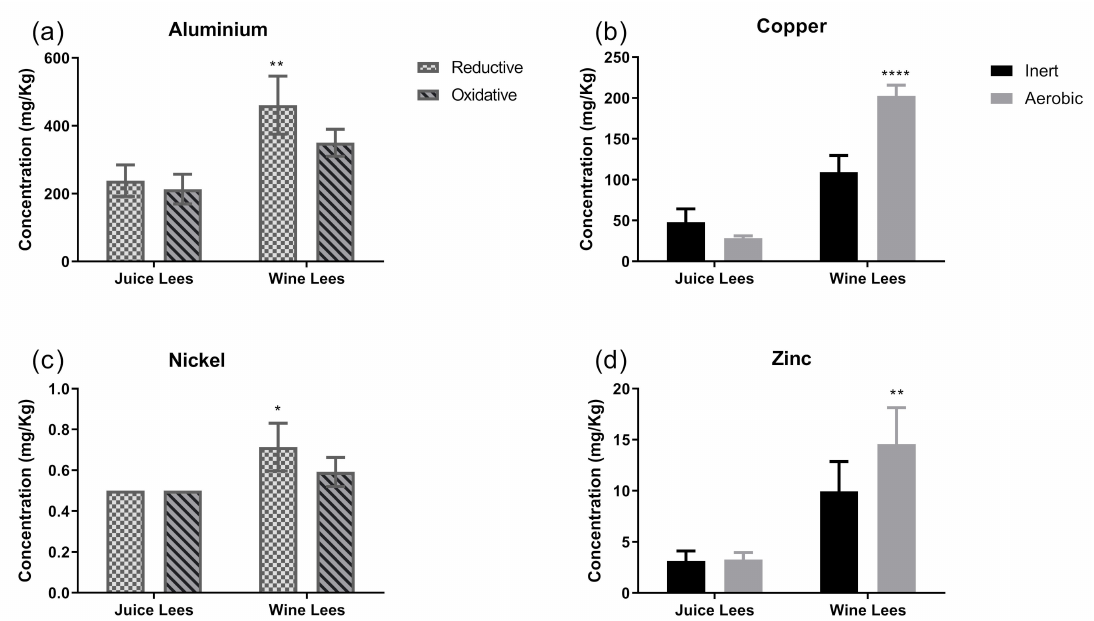
Figure 5. E ff ects of oxygen exposure during pressing and handling on the concentration of Al ( a ), Cu ( b ), Ni ( c ), and Zn ( d ) in Chardonnay juice lees and wine lees for inert pressing (“Inert”, black), aerobic pressing (“Aerobic”, grey), reductive handling (“Reductive”, chequered grey), and oxidative handling (“Oxidative”, striped grey) treatments. For p value > 0.05; * p value ≤ 0.05; ** p value ≤ 0.01; *** p value ≤ 0.001; **** p value ≤